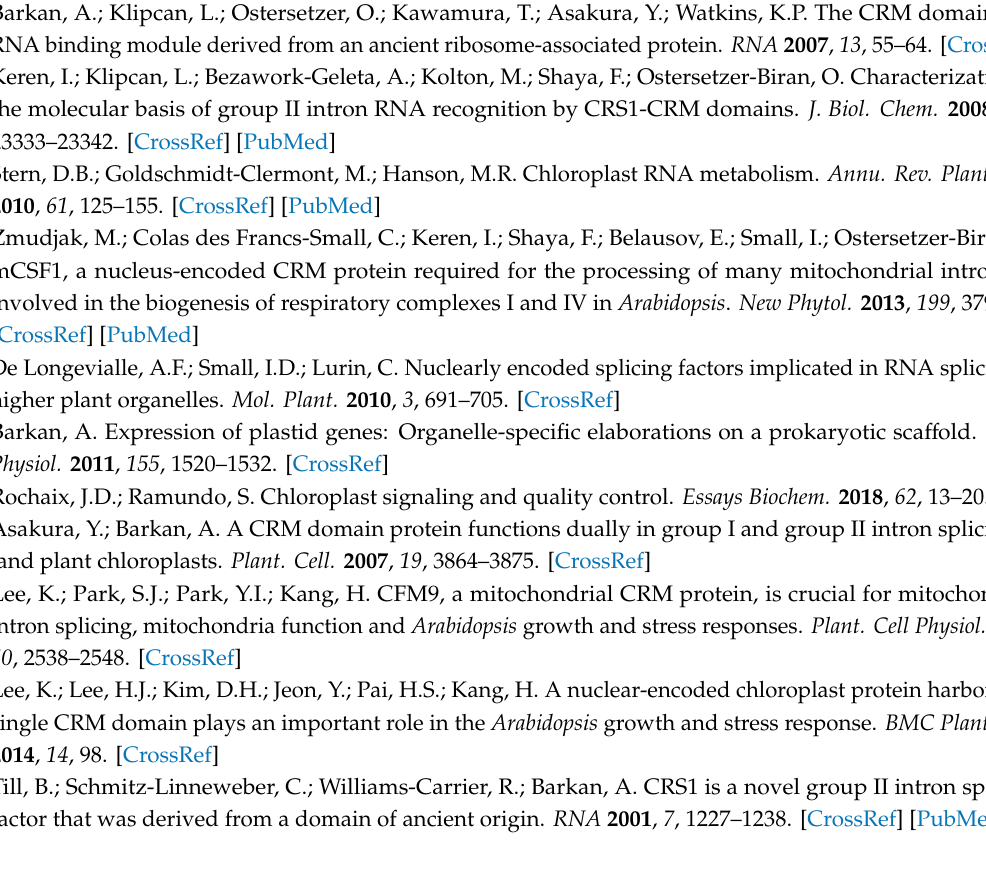
Figure S1: MEME analysis shows each motif of the 14 CRM protein in rice, Figure S2: Mutation types of oscfm2-1 and oscfm2-2 mutants, Figure S3: Splicing analysis of chloroplast gene introns, Figure S4: Expression analysis of CRS1 subfamily genes in WT rice plants and oscfm2-1 and oscfm2-2 mutants, Table S1: Primers for this study, Table S2 Characteristics of 14 CRM domain proteins in